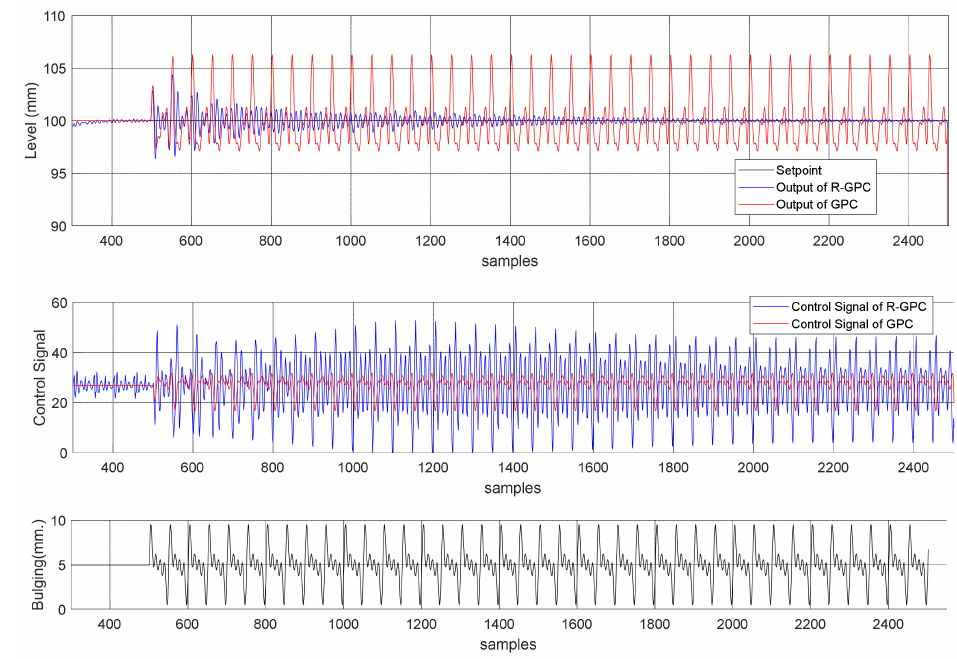
Figure 13. GPC (red) and repetitive structure (blue)